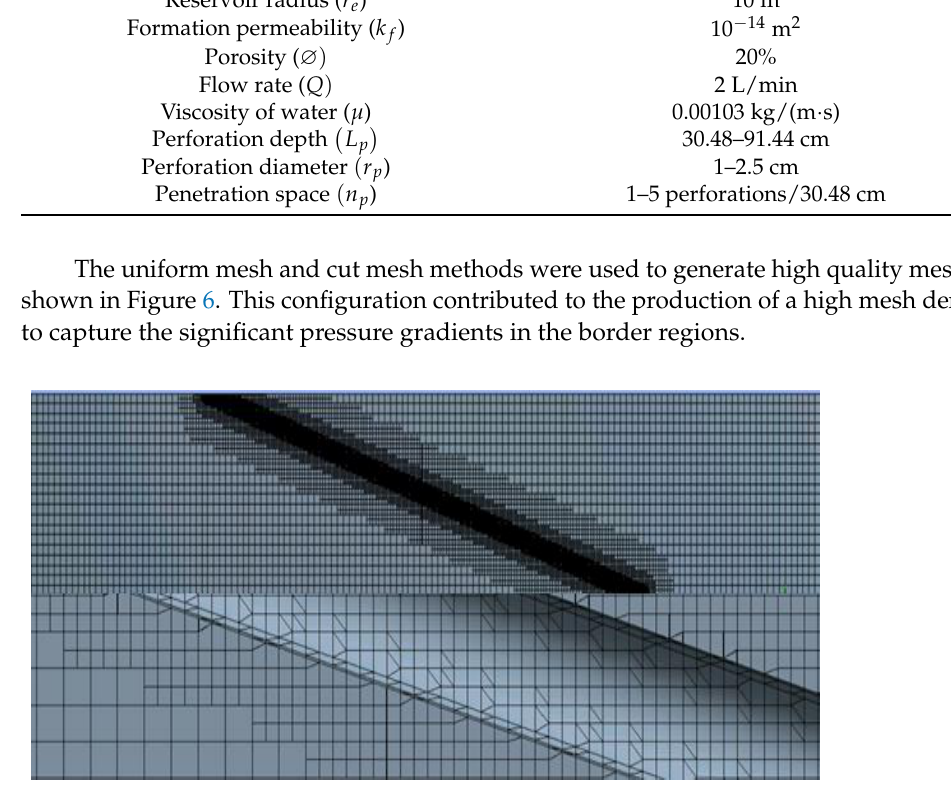
Figure 6. The shape of the uniform configuration mesh used in CFD simulations. Table 1. Dimensions and properties of the vertical near-wellbore region and the ranges of three investigated parameters.